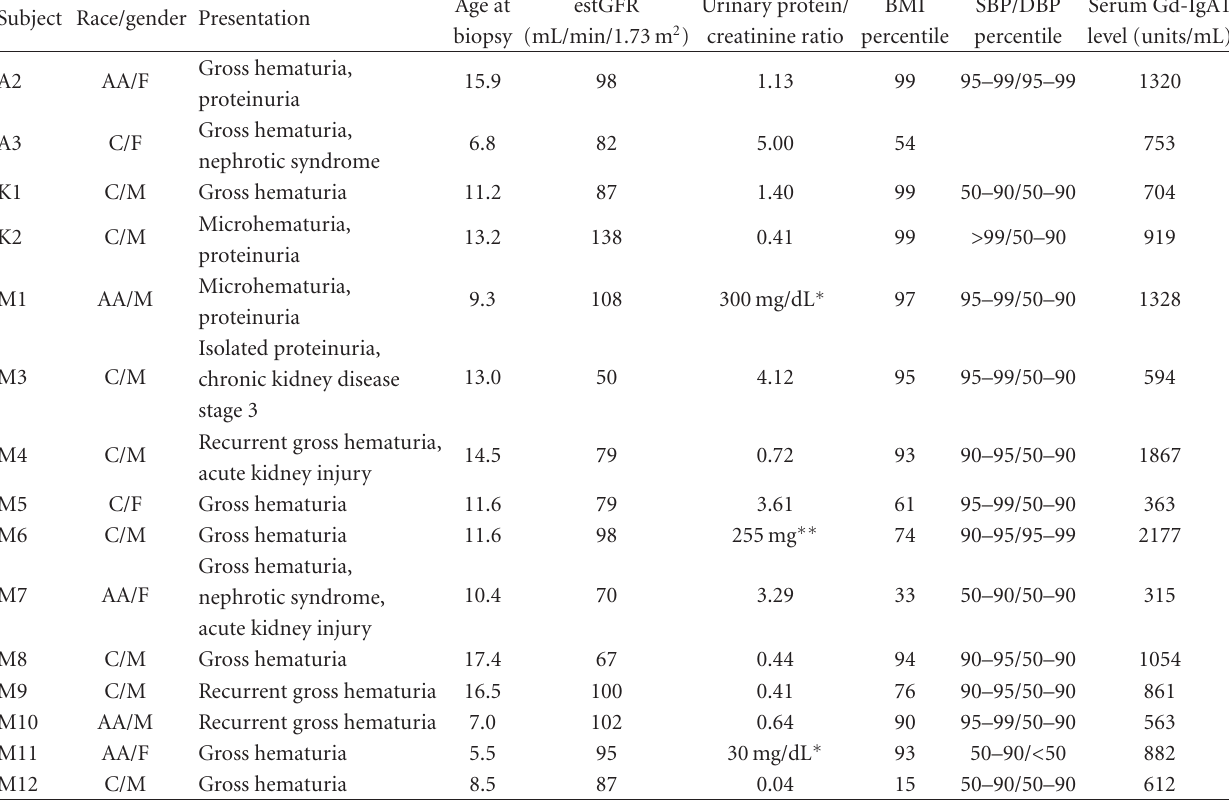
Table 2: Clinical and demographic features of individual subjects (prevalent cases).